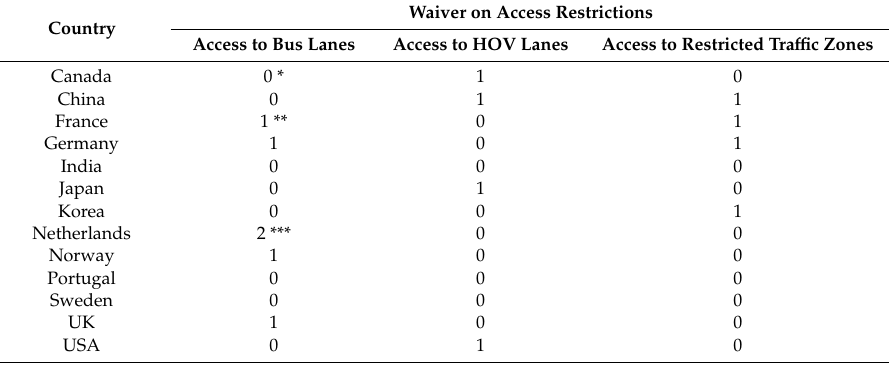
Table A2. Summary of policy value for waiver in 2018 [2,43].